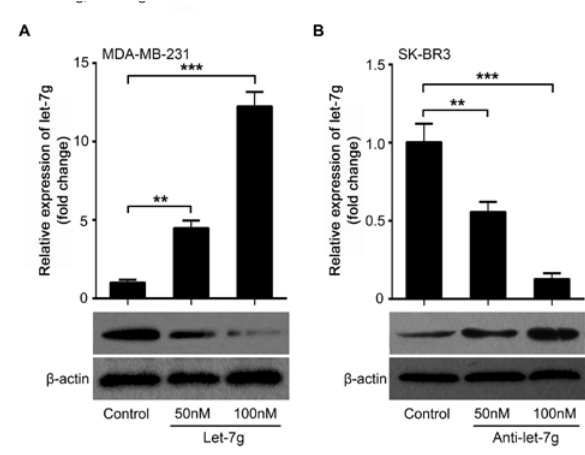
Figure 2: Let-7g inhibits FOXC2 expression in breast cancer cells. (A) The levels of FOXC2 protein were examined in MDA-MB-231 cells with the treatment of let-7g by Western blot analysis. The successful transfection of let-7g was confirmed by qRT-PCR analysis. (B) The levels of FOXC2 protein were determined in SK-BR3 cells with anti- let-7g treatment using Western blot. The successful transfection of anti-let-7g was accessed by qRT-PCR. (Statistical differences: ** P < 0.01, *** P < 0.001; Student’s t